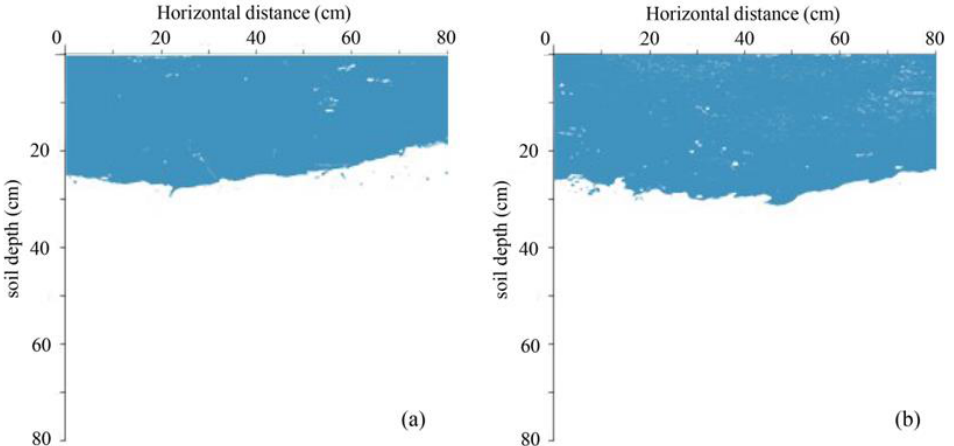
Figure 3. The vertical soil profiles. (a) is the result of the first dam site profile dyeing test; (b) is the result of the second dam site profile dyeing test.